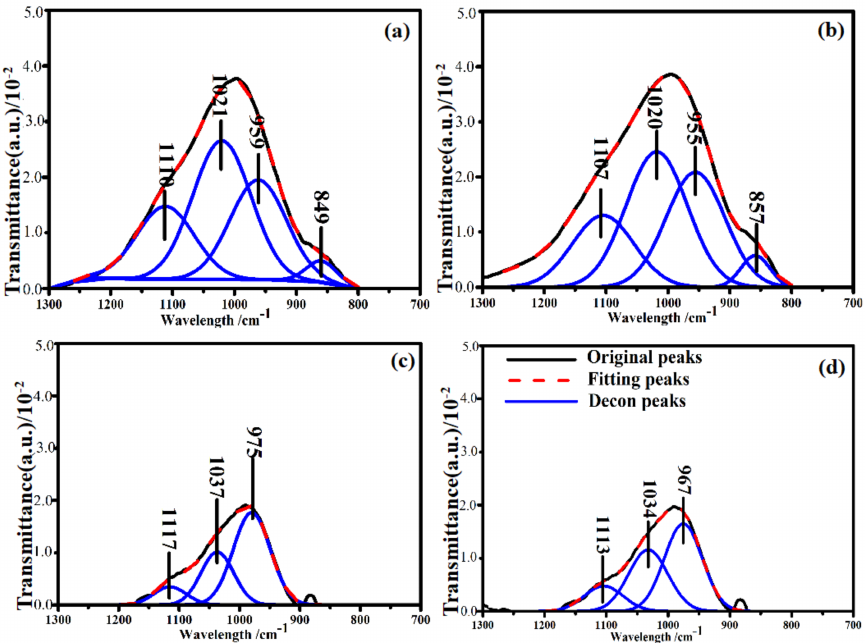
Figure 6. Deconvolution of the FTIR spectra of samples calcined at 600 ◦ C in the region between 1300 and 800 cm − 1 . The reaction time of ( a ) 0.5 h; ( b ) 1 h; ( c ) 1.5 h; ( d ) 2 h.